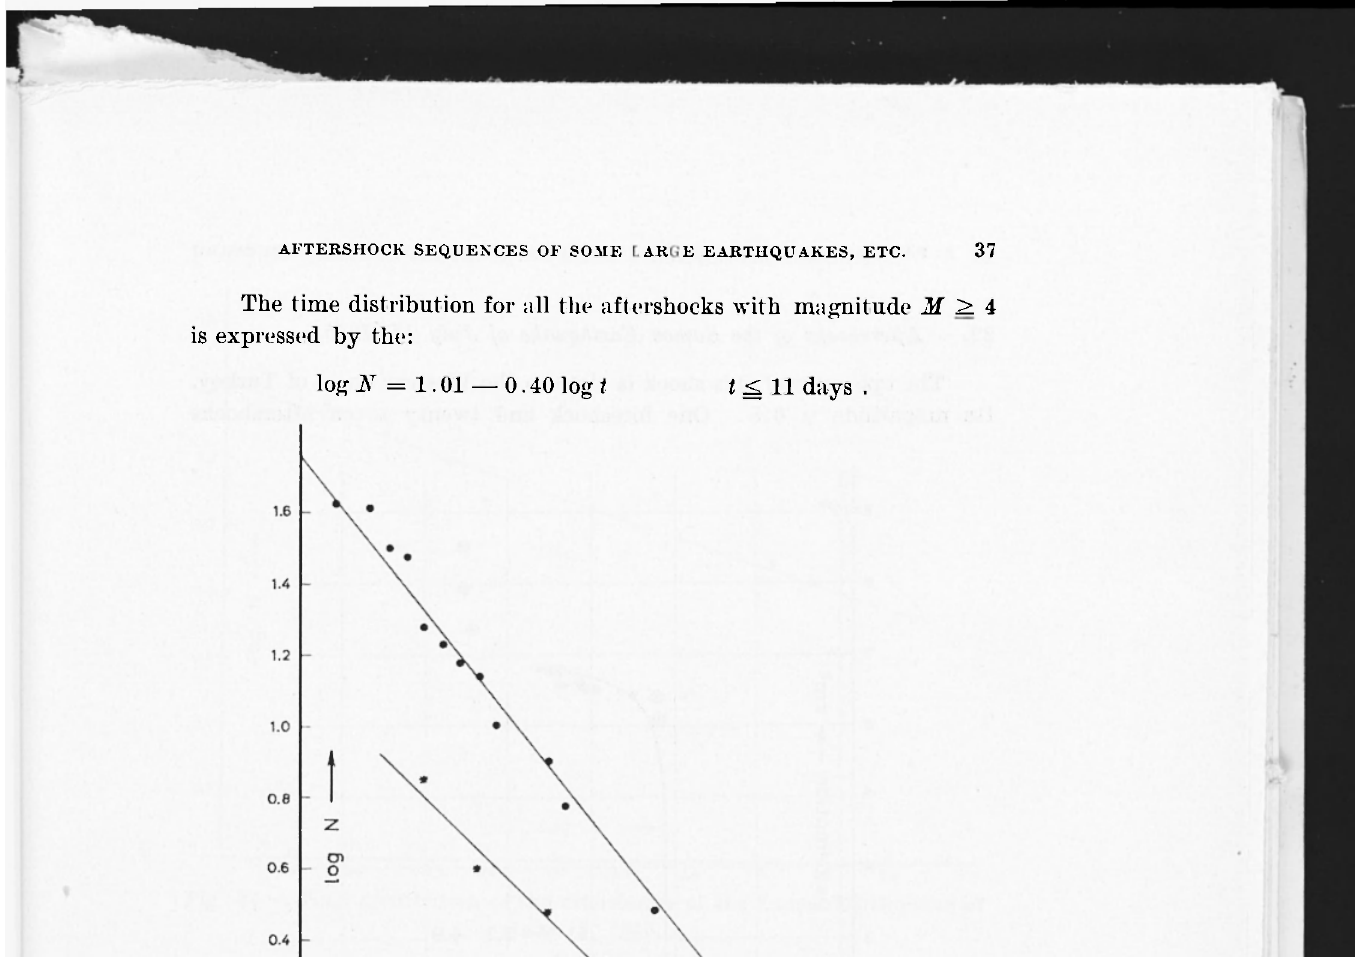
Fig. 25 - Distribution of the Magnitudes of the foreshoeks and aftershocks of the Volos Earthquake of April 19,